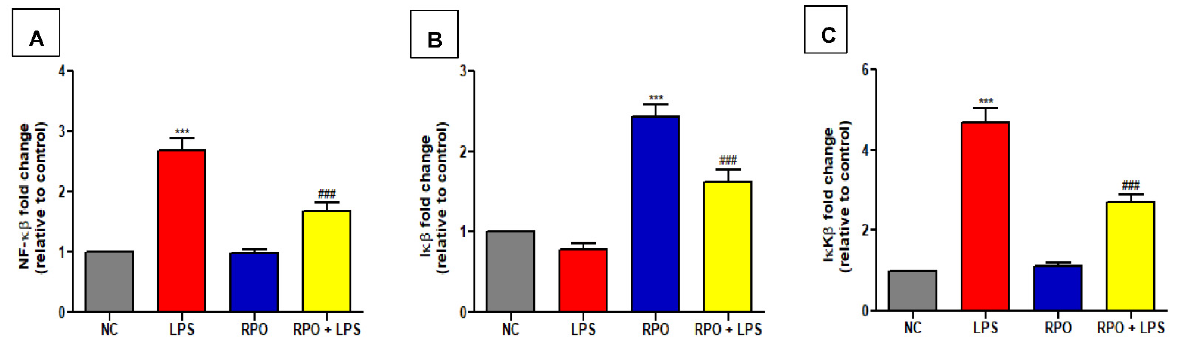
Figure 4. RPO inhibits NF- κβ activation in LPS-induced rats. RPO reduced hepatic ( A ) NF- κβ ( B ) I κβ and ( C ) I κ K β gene expression. Data are mean ± SEM ( n = 8–10). *** p < 0.001 as significant difference compared with NC. ### p < 0.001 as significant difference compared with LPS. LPS (lipopolysaccharide), NC (normal control), RPO (red palm oil). A